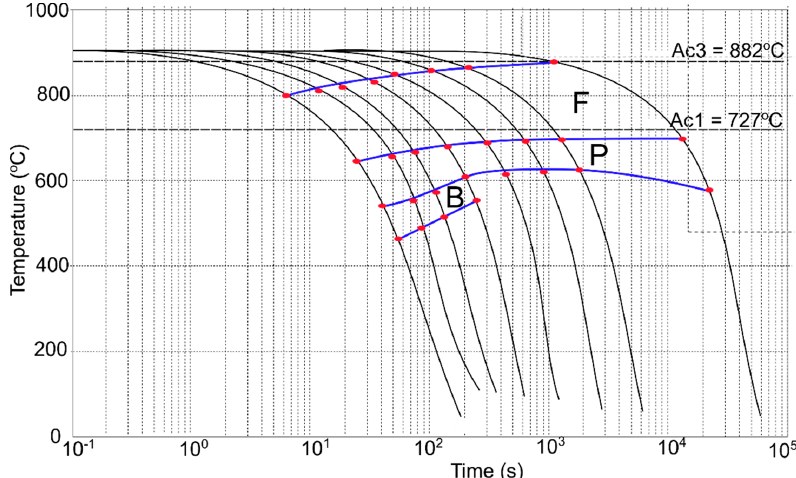
Figure 9. Continuous-cooling-transformation (CCT) diagram of the investigated low-carbon structural steel; blue lines denote the phase transformation zones.